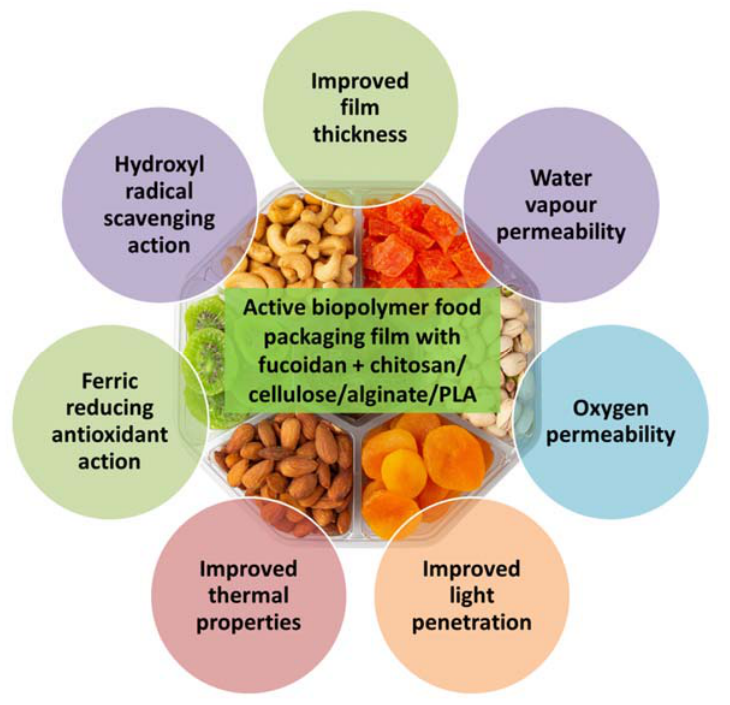
Figure 5. Beneficial properties of active biopolymer food packaging films prepared from fucoidan blended with other polymers, such as chitosan, cellulose, alginate or polylactic acid.